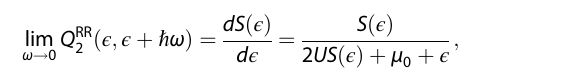
Fig. 4 Phase diagram for the nonlinear transport regimes in 2D Dirac materials. Colormap plot for g ¼ j σ ð 3 Þ versus chemical potential μ and relaxation rate Γ ( μ ) in the full conserving and constant- Γ models depicted in ( a ) and ( b ), respectively. The sign of σ ð 3 Þ is written on the plot where two sign-switch borders are highlighted by dashed red lines. Green and blue dashed lines stand for the dc contour lines with g = 1 and g = 0.1,